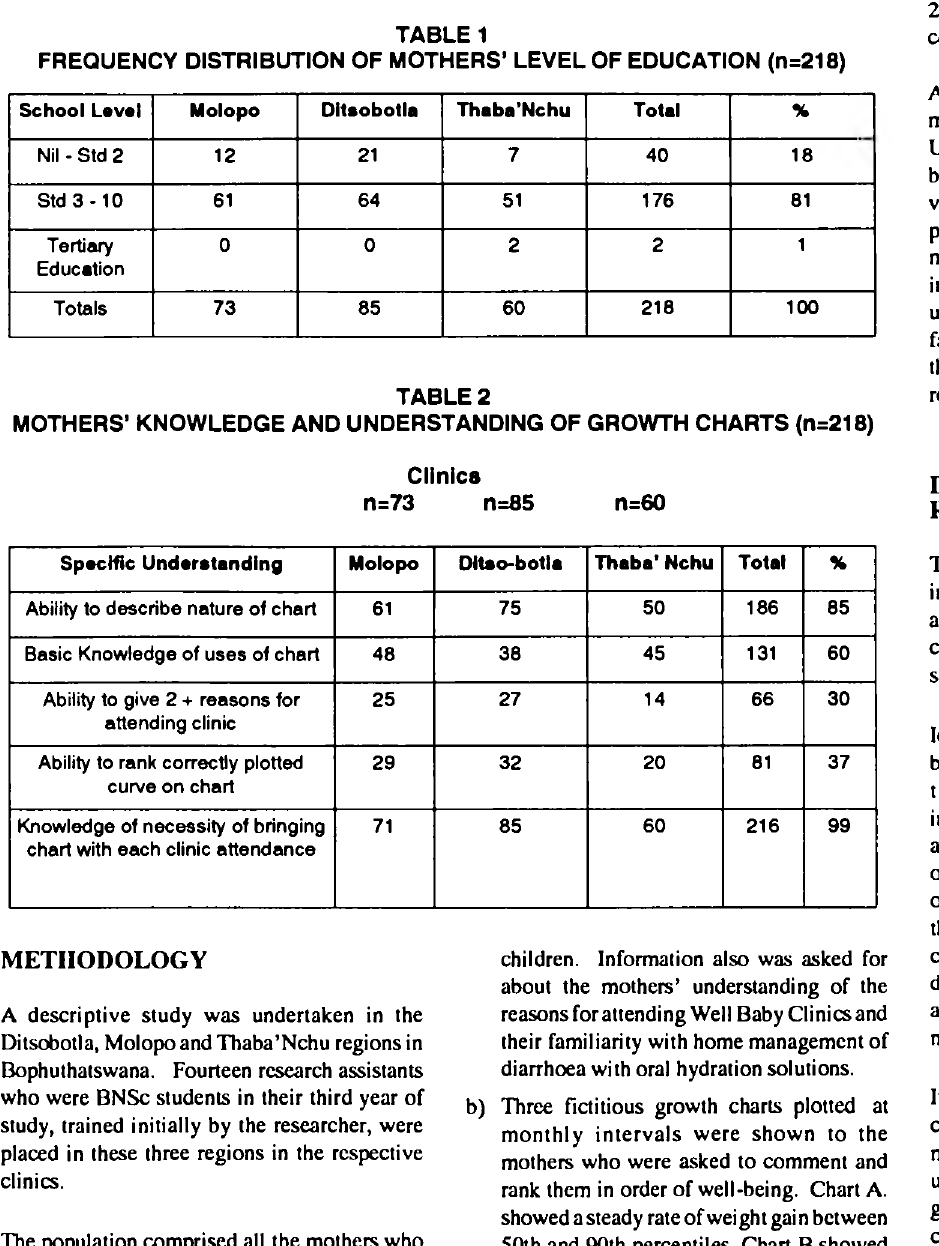
MOTHERS’ KNOWLEDGE AND UNDERSTANDING OF GROWTH CHARTS